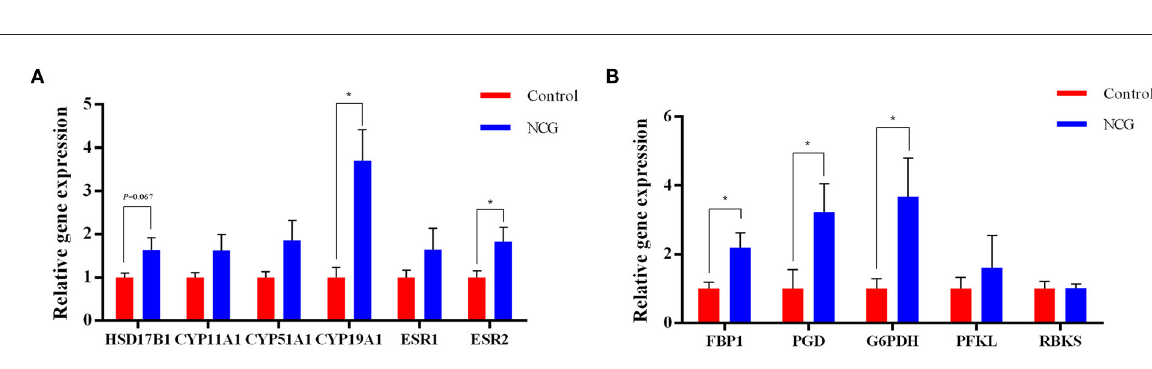
FIGURE8 Relative gene expression of the genes associated with steroid biosynthesis (A) and the pentose phosphate pathway (B) determined using RT-PCR. The data are presented as the mean and standard error, n = 6, * P <